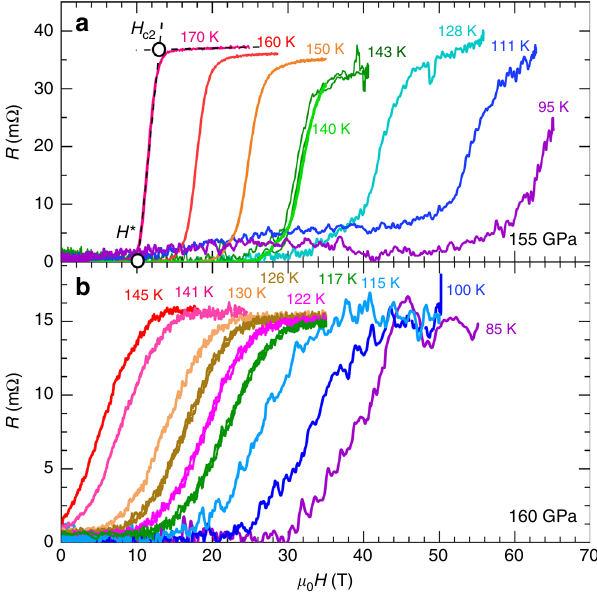
Fig. 3 Upper critical fi elds for H 3 S as a function of the temperature. Resistance as a function of the fi eld μ 0 H for the H 3 S samples under a p = 155 GPa and b 160 GPa and for several temperatures. This data was collected under continuous and pulsed fi elds. Two black dashed lines extrapolate the resistance in the normal state and the slope at the middle point of the resistive transition. The open circle symbol at the intersection of the two black dashed lines illustrates the position of H c2 . The open circle symbol at the intersect of the x -axis and the black dashed line illustrates the position of H * which marks the onset of dissipation. Source data are provided as a Source Data fi